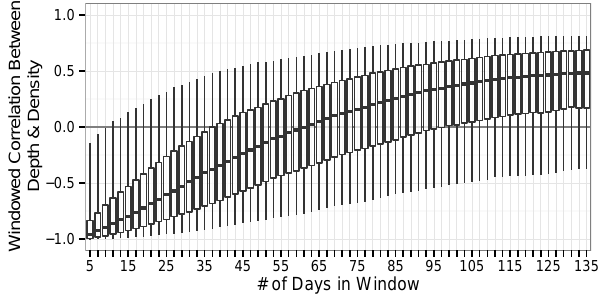
Fig. 2. Correlation between snow depth and bulk density prior to peak SWE as a function of window size (number of days used to compute the correlation). Ten thousand points were randomly se- lected from our full data set (described below) and odd-length win- dows around each expanded from 5 to 135 days for calculating the correlation whenever no more than 1% of days were missing. Boxes represent the inner 50th quantile and whiskers the inner 90th quan- tile of correlations for each window. Because larger windows with less that 1% missing points become more difficult to find prior to peak SWE for randomly selected points, the number of correlations over which boxplots are computed ranges from roughly 7000 at the 5-day window to 1500 at the 135-day